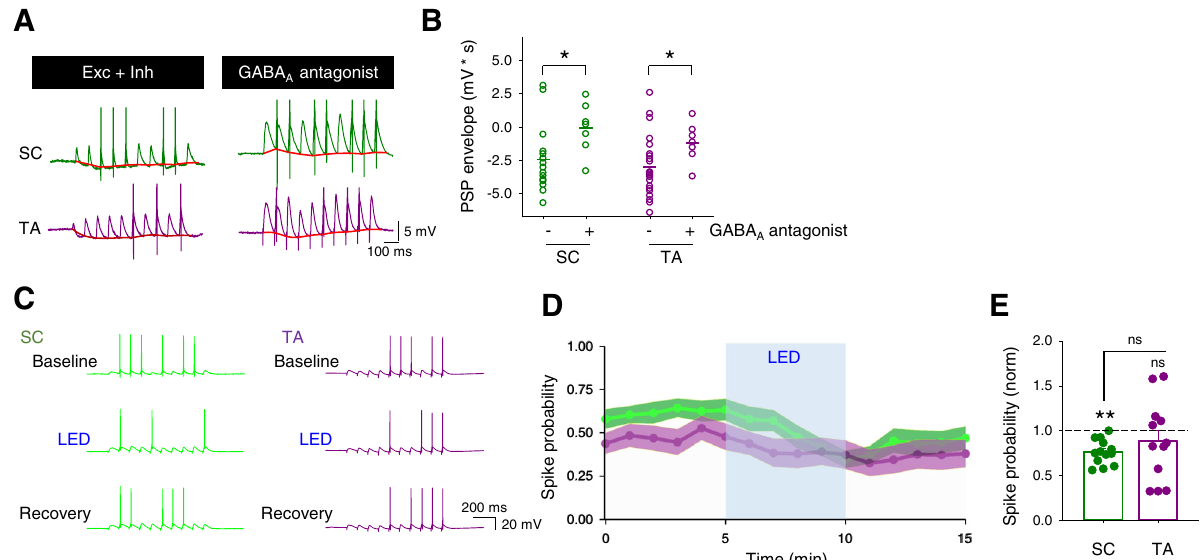
Fig. 7 Cholinergic enhancement of CA1 responses to temporoammonic inputs is mediated by inhibition. A , B Inhibition of GABA A receptors with picrotoxin (50 µ M) reduced the underlying hyperpolarising envelope (red) in response to 10 stimuli at 10 Hz for both SC (green; control, n = 15 from 5 mice; GABA A antagonist, n = 7 from 2 mice; p = 0.028, two-tailed unpaired t -test) and TA (purple; control, n = 23 from 9 mice; GABA A antagonist, n = 7 from 2 mice; p = 0.021, two-tailed unpaired t -test) input pathways to CA1 pyramidal neurons. C – E In the presence of a GABA A receptor antagonist, light stimulation of cholinergic fi bres (LED) reduced spike probability for SC pathway but produced no change in the TA pathway (SC spike probability, n = 13 from 7 mice, p = 0.005; TA spike probability, n = 12 from 6 mice, p = 0.38; SC vs TA spike probability, p = 0.37; inter-group comparisons one-way ANOVA with post hoc Bonferroni correction. Within-group comparisons two-tailed paired t -test). Data are mean ± SEM; ** p < 0.01, * p < 0.05. Source data are provided as a Source Data fi